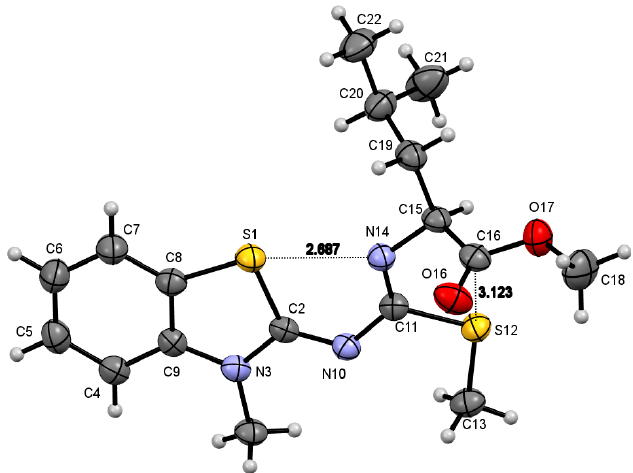
Figure 6. X-ray diffraction structure of compound 9f . Bond Lengths (Å). S1–C2 1.757(5),